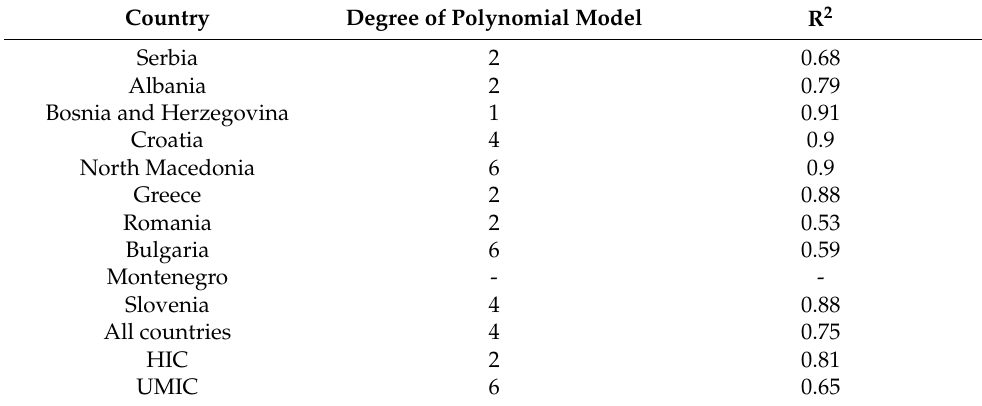
Table 4. Multiple regression